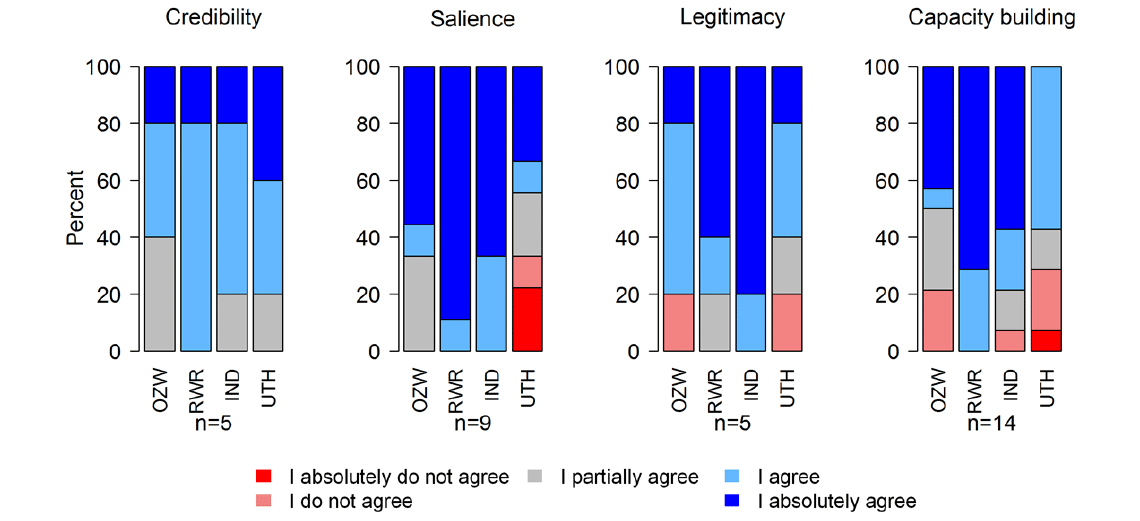
Fig. 5 . Evaluation of the local researchers regarding the credibility of scenarios, the relevance of the scenario process and outcomes, the salience of the scenario process, and the contribution of the scenario process and outcomes to capacity building. Dark blue represents the maximum score for each group and red the lowest score. More details on the survey are given in Table A2.1 and Table A2.2; the number of questions (n) in each criterion is indicated below the subfigures. OZW = the Oum Zessar watershed,